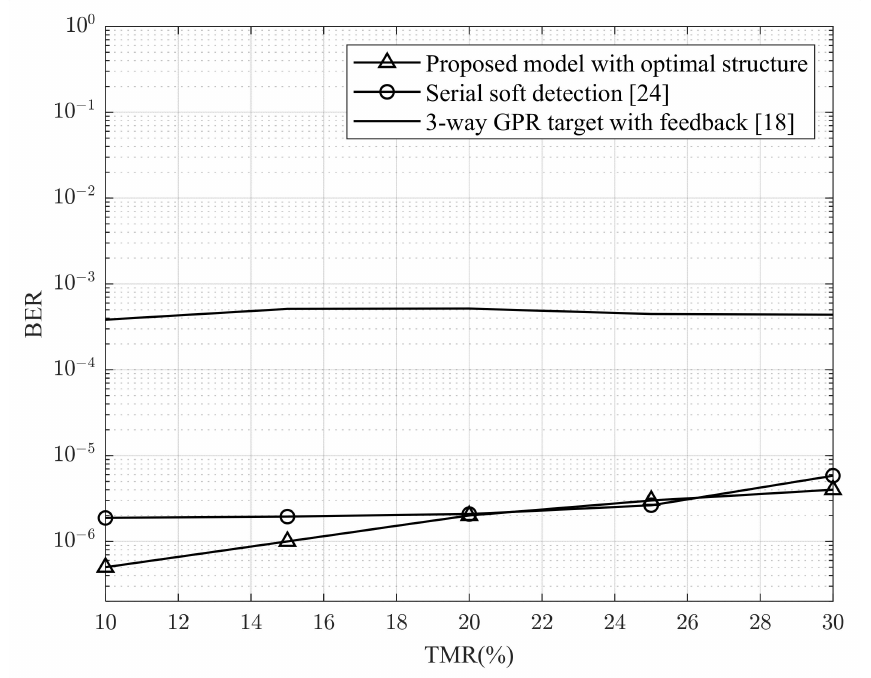
Figure 6. BER performance of the proposed model according to TMR at SNR = 15 dB [18,24].